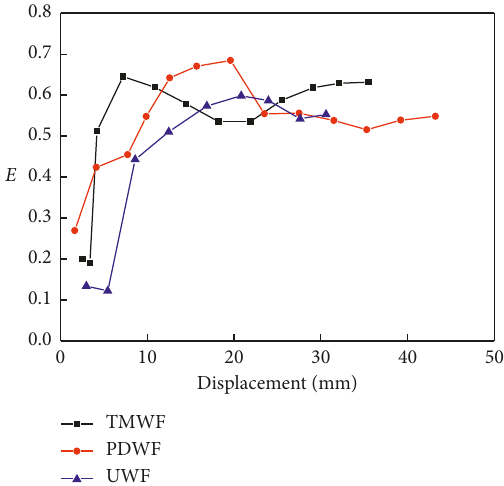
Figure 14: Energy dissipation curve.